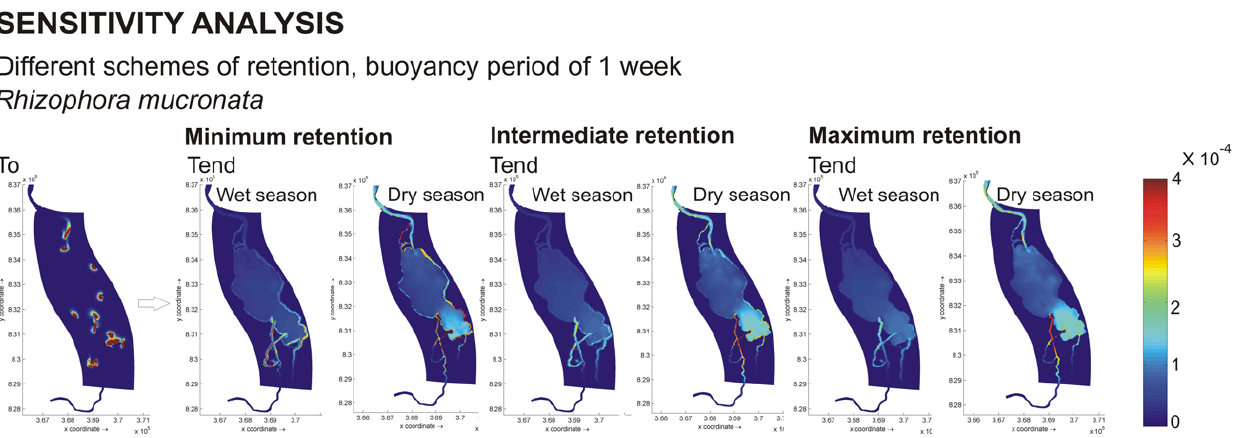
Fig. 4b. Results of the sensitivity analysis: distribution patterns for the species Rhizophora mucronata when varying the retention schemes from minimum, intermediate to maximum retention values. Red, yellow and light blue colours indicate a high, medium and low concentration of propagules